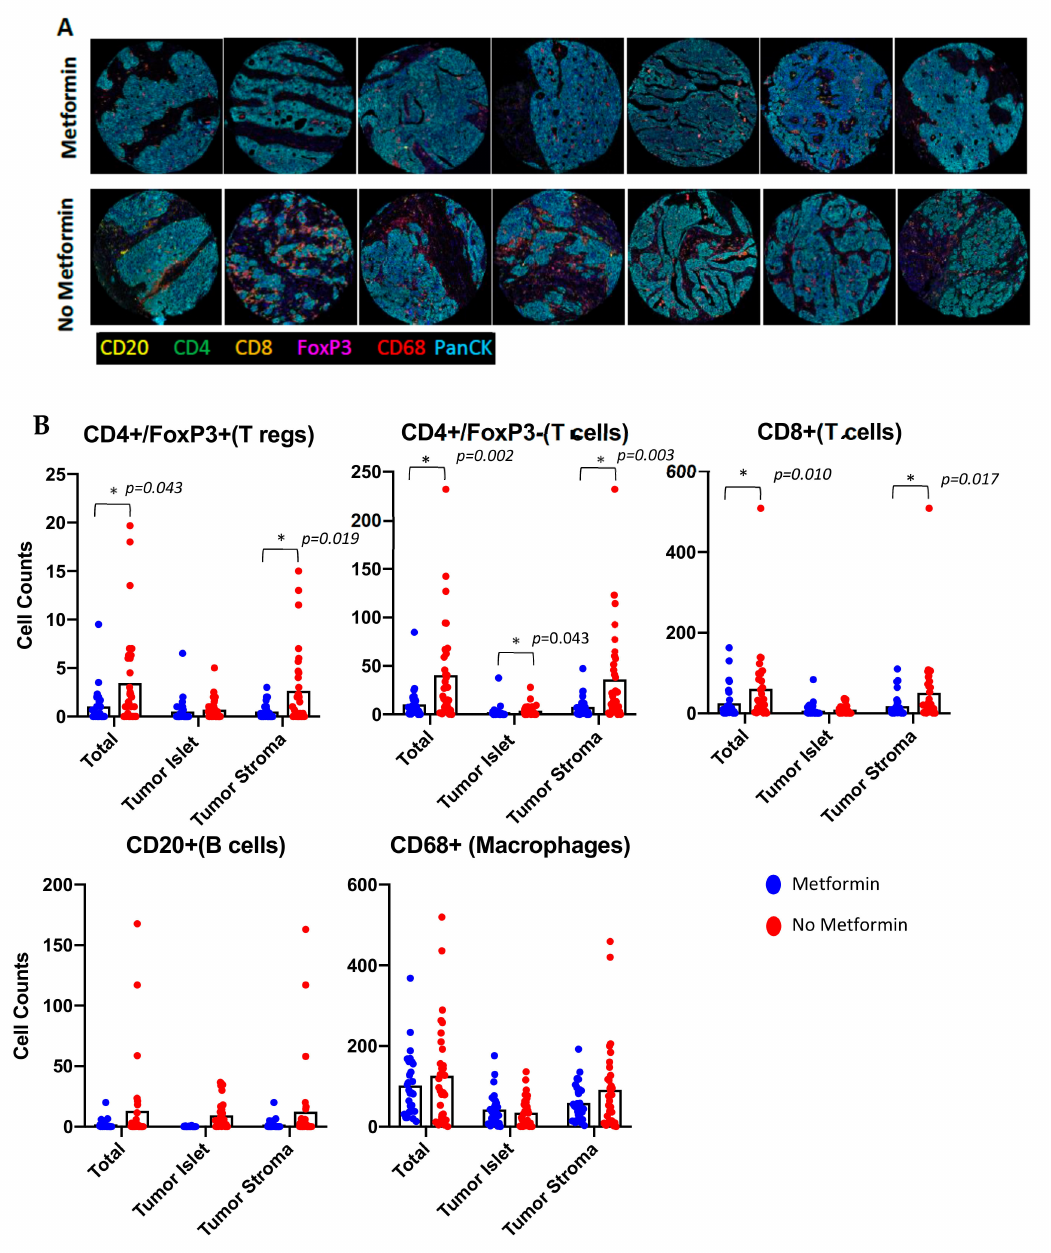
Figure 3. Metformin therapy was associated with a reduction in the number of T-regs. ( A ) Repre- sentative confocal microscopy immunofluorescent images of metformin-treated and non-metformin- treated human samples (10 × ). ( B ) Quantification of immunologic phenotypes across tumor islet and tumor stromal segments as well as total cores. Phenotypes counted included CD4 + /Foxp3 − (Th-cells), CD4 + /Foxp3 + (T-regs), CD8 + (Tc-cells), CD20 + (B-cells), CD68 + (Macrophages), and CK + (Tumor Cells). * indicates statistical